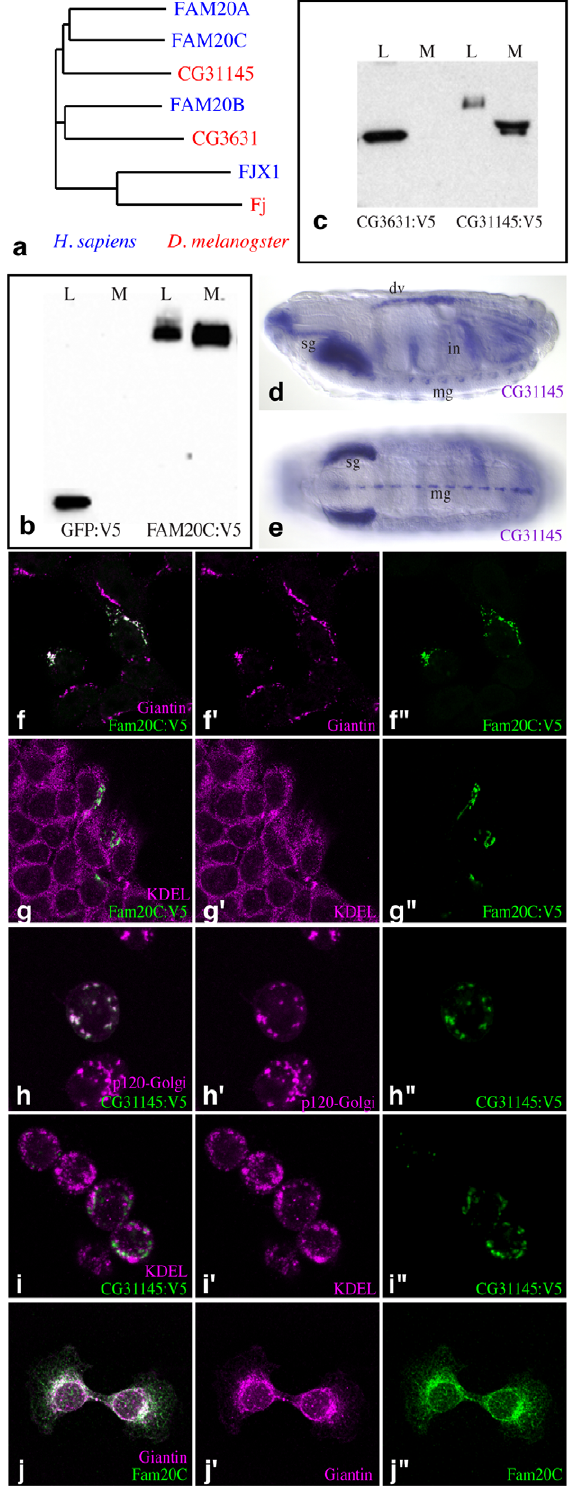
Figure 1. Localization of FAM20C proteins. a) Relative amino acid sequence similarity amongst Golgi kinases in flies (red) and humans (blue). Sequences compared were: Drosophila CG3631 (UniProt Q95T10), CG31145 (Q9VCK5), Four-jointed (Fj, P54360), human FAM20A (Q96MK3), FAM20B (O75063), FAM20C (Q8IXL6), and Four-jointed box protein 1 (Fjx1, Q86VR8). b) Western blot showing that FAM20C:V5 expressed in cultured cells is detected in both lysate (L) and